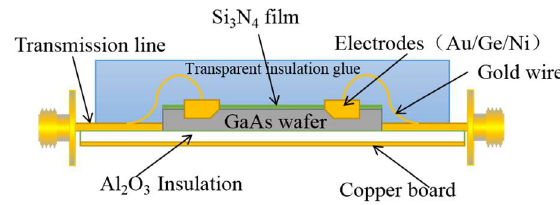
Figure 3. Cross-section of the SI-GaAs PCSS.